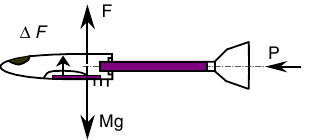
Figure 7 Floating mechanism of the